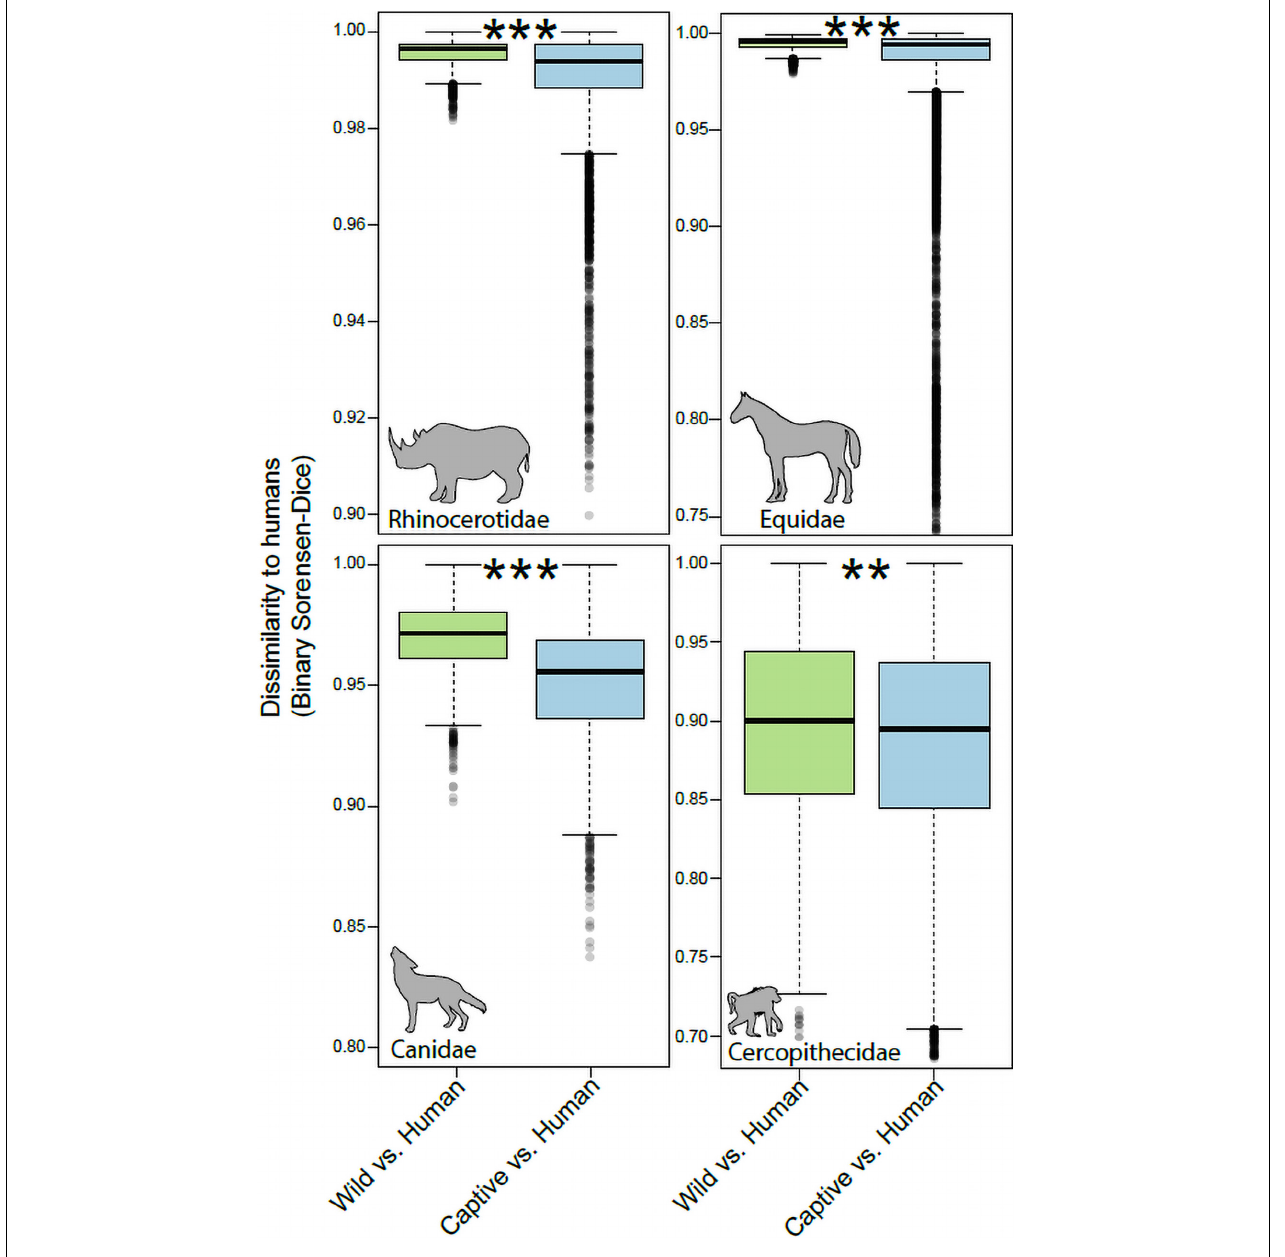
FIGURE 2 | Humanization of the gut microbiota in captive Rhinocerotidae, Equidae, Canidae, and Cercopithecidae. Boxplots show microbiota dissimilarities (binary Sorensen-Dice) between humans and wild mammals (green boxes) and between humans and captive mammals (purple boxes). Each box shows median and interquartile range for a comparison including a single mammalian family. Significant differences between boxplots within each panel are denoted with asterisks; ** p < 0.01, *** p = 0.001; non-parametric Monte-Carlo permutation